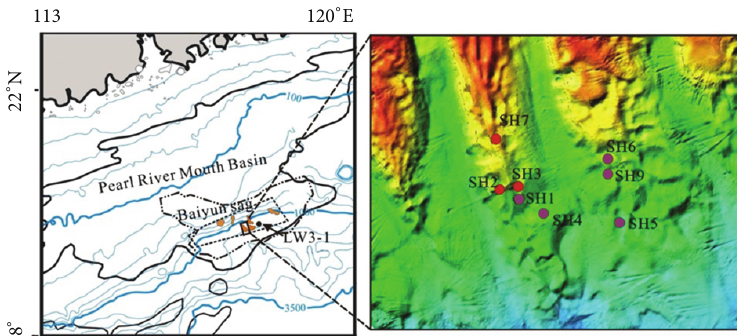
Figure 1: Areas of gas hydrate exploration and drilling area with drilling sites in the northern part of the South China Sea [40]. (Red dots, gas hydrate samples obtained; dark purple dots, no gas hydrate samples obtained.)